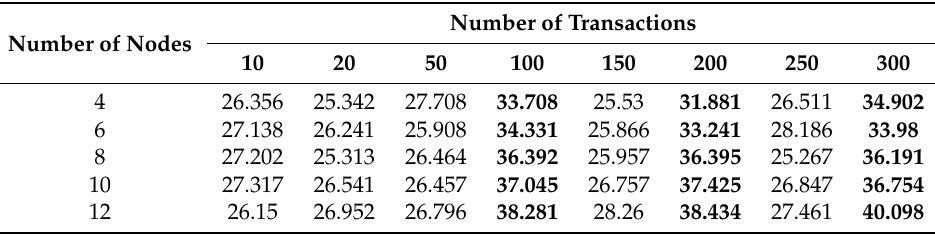
Table 2. Delay based on the Kafka consensus algorithm.